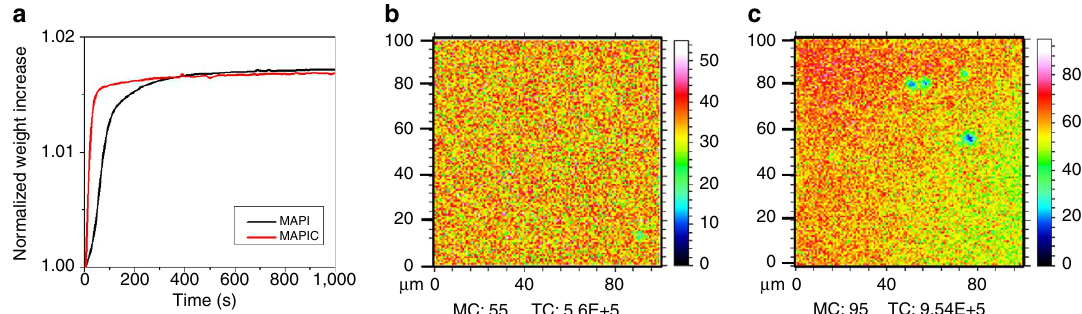
Figure 2 | Oxygen diffusion. ( a ) Isothermal gravimetric analysis plot (IGA) of CH 3 NH 3 PbI 3 (MAPI) and CH 3 NH 3 PbI 3 (Cl) (MAPIC) thin films coated on non-conductive cleaned glass with 30min of Helium soaking before oxygen exposure, where t ¼ 0 corresponds to the time at which oxygen was introduced into the system. ( b , c ) ToF-SIMS surface images (100 (cid:3) 100 m m) of CH 3 NH 3 PbI 3 and CH 3 NH 3 PbI 3 (Cl) respectively after exposure to dry air flow with no illumination, where the maximum counts (MC) and the total number of secondary oxygen ion counts (TC) are shown with the colour scales corresponding to the interval